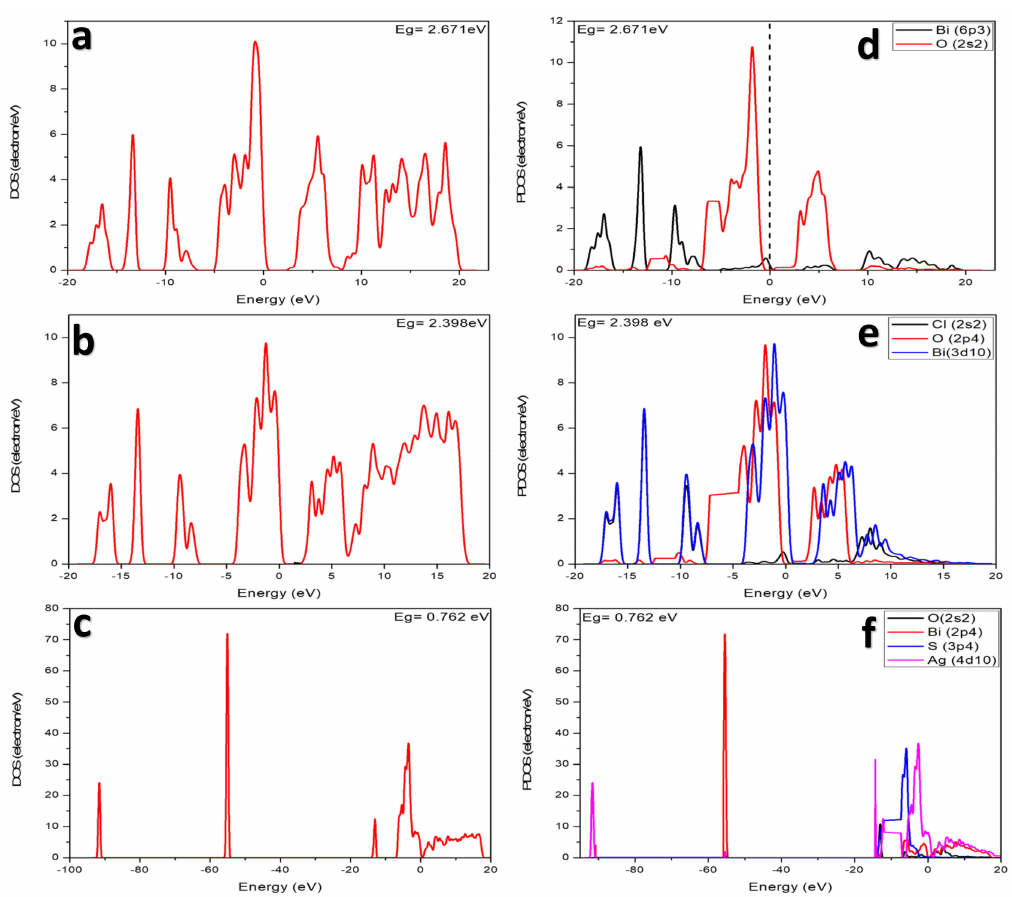
Figure 4. Calculated DOS of: ( a ) BiOCl, ( b ) BiOCl/Ag 2 S, ( c ) BiOCl/Bi 2 O 3 , and PDOS of: ( d ) BiOCl, ( e ) BiOCl/Ag 2 S, and ( f ) BiOCl/Bi 2 O 3